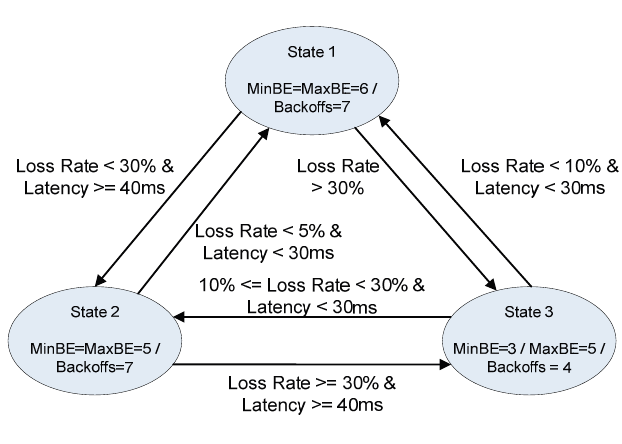
Figure 6. The original DR-MAC.